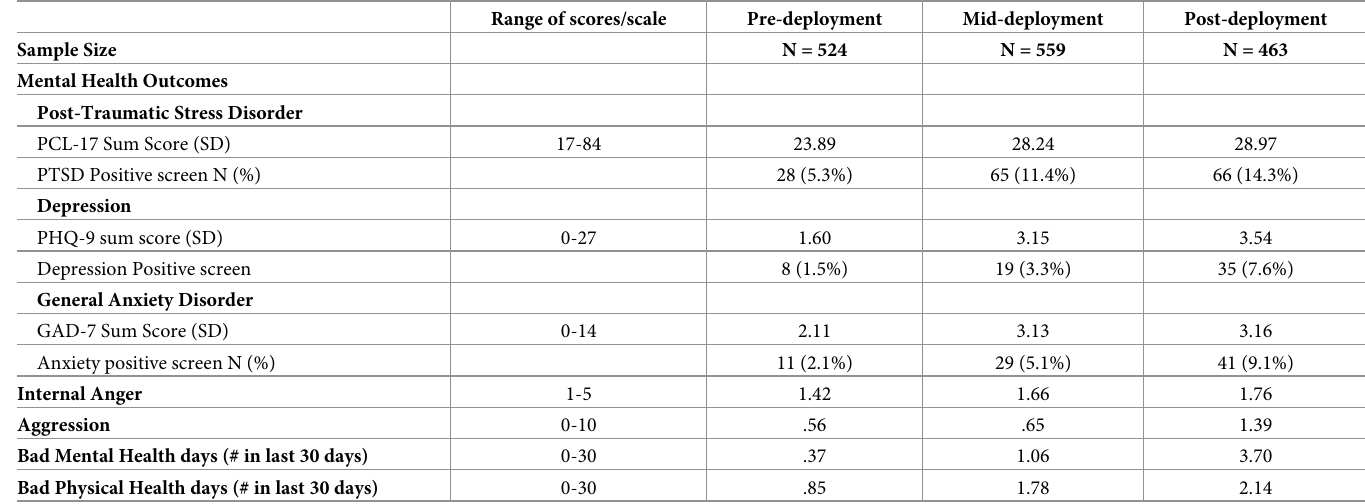
Table 2. Mental health outcomes across time